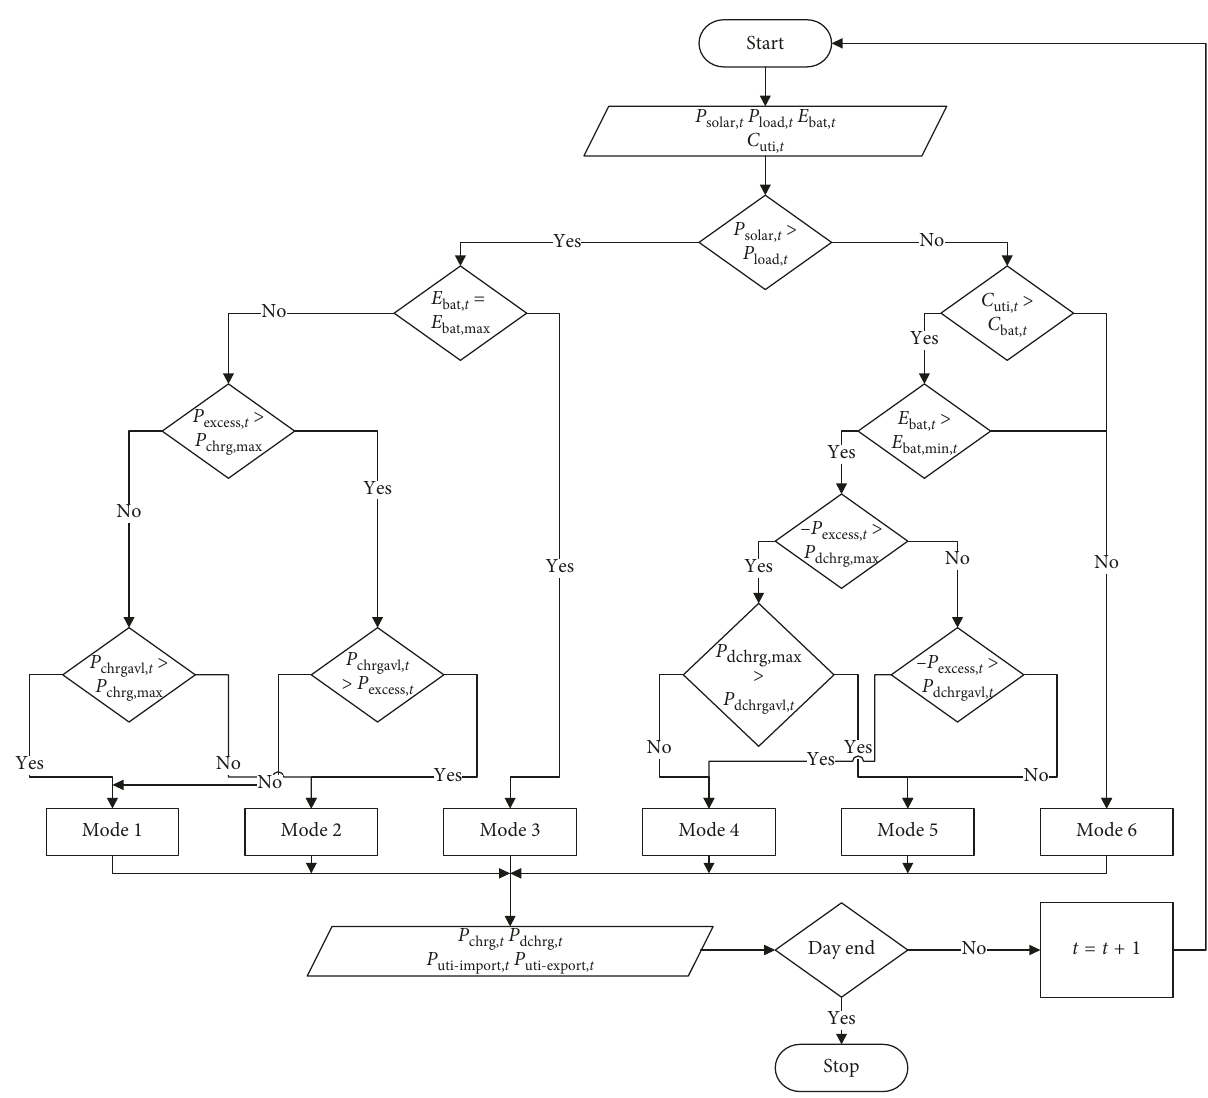
Figure 3: Rule-based algorithm for day-ahead scheduling. Table 1: Functioning modes of the